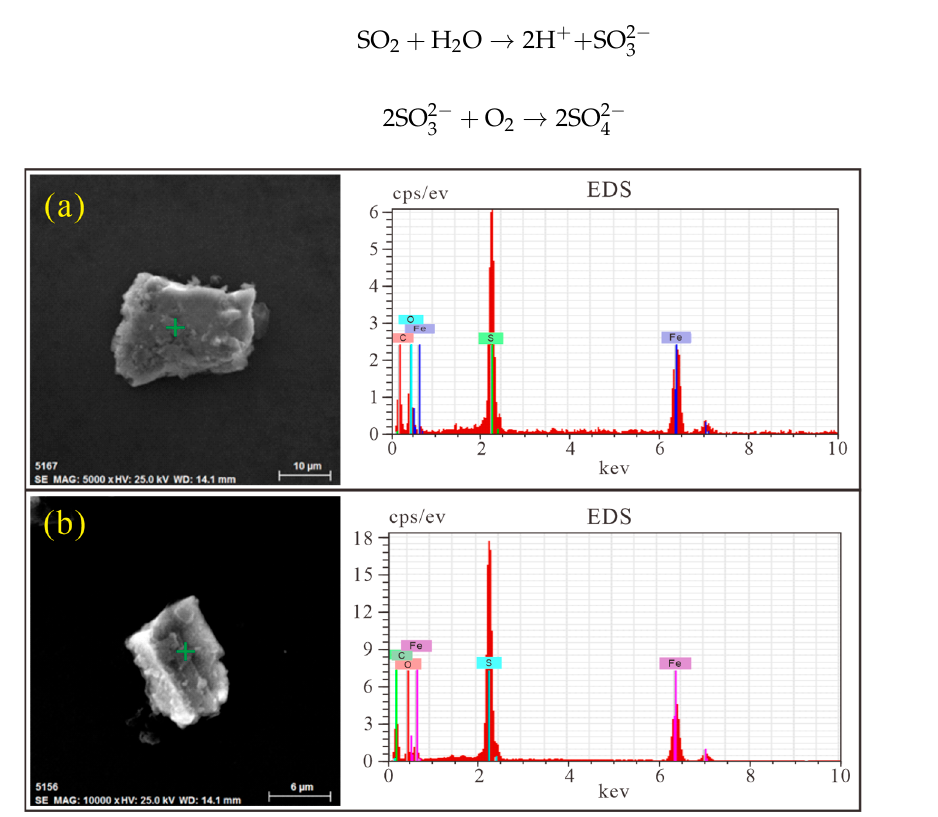
Figure 12. Analysis of pyrite surface after microbial action: ( a ) is the Coal-pyrite 1; ( b ) is the Coal- pyrite